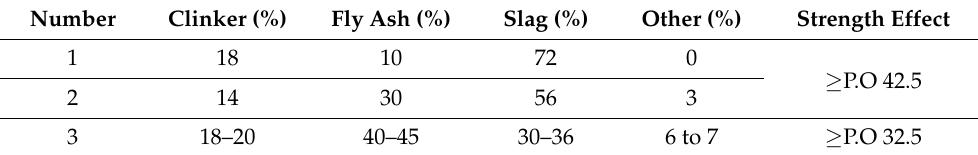
Table 1. Ratios and strength effects of common fly-ash-based cementitious materials. Number Clinker